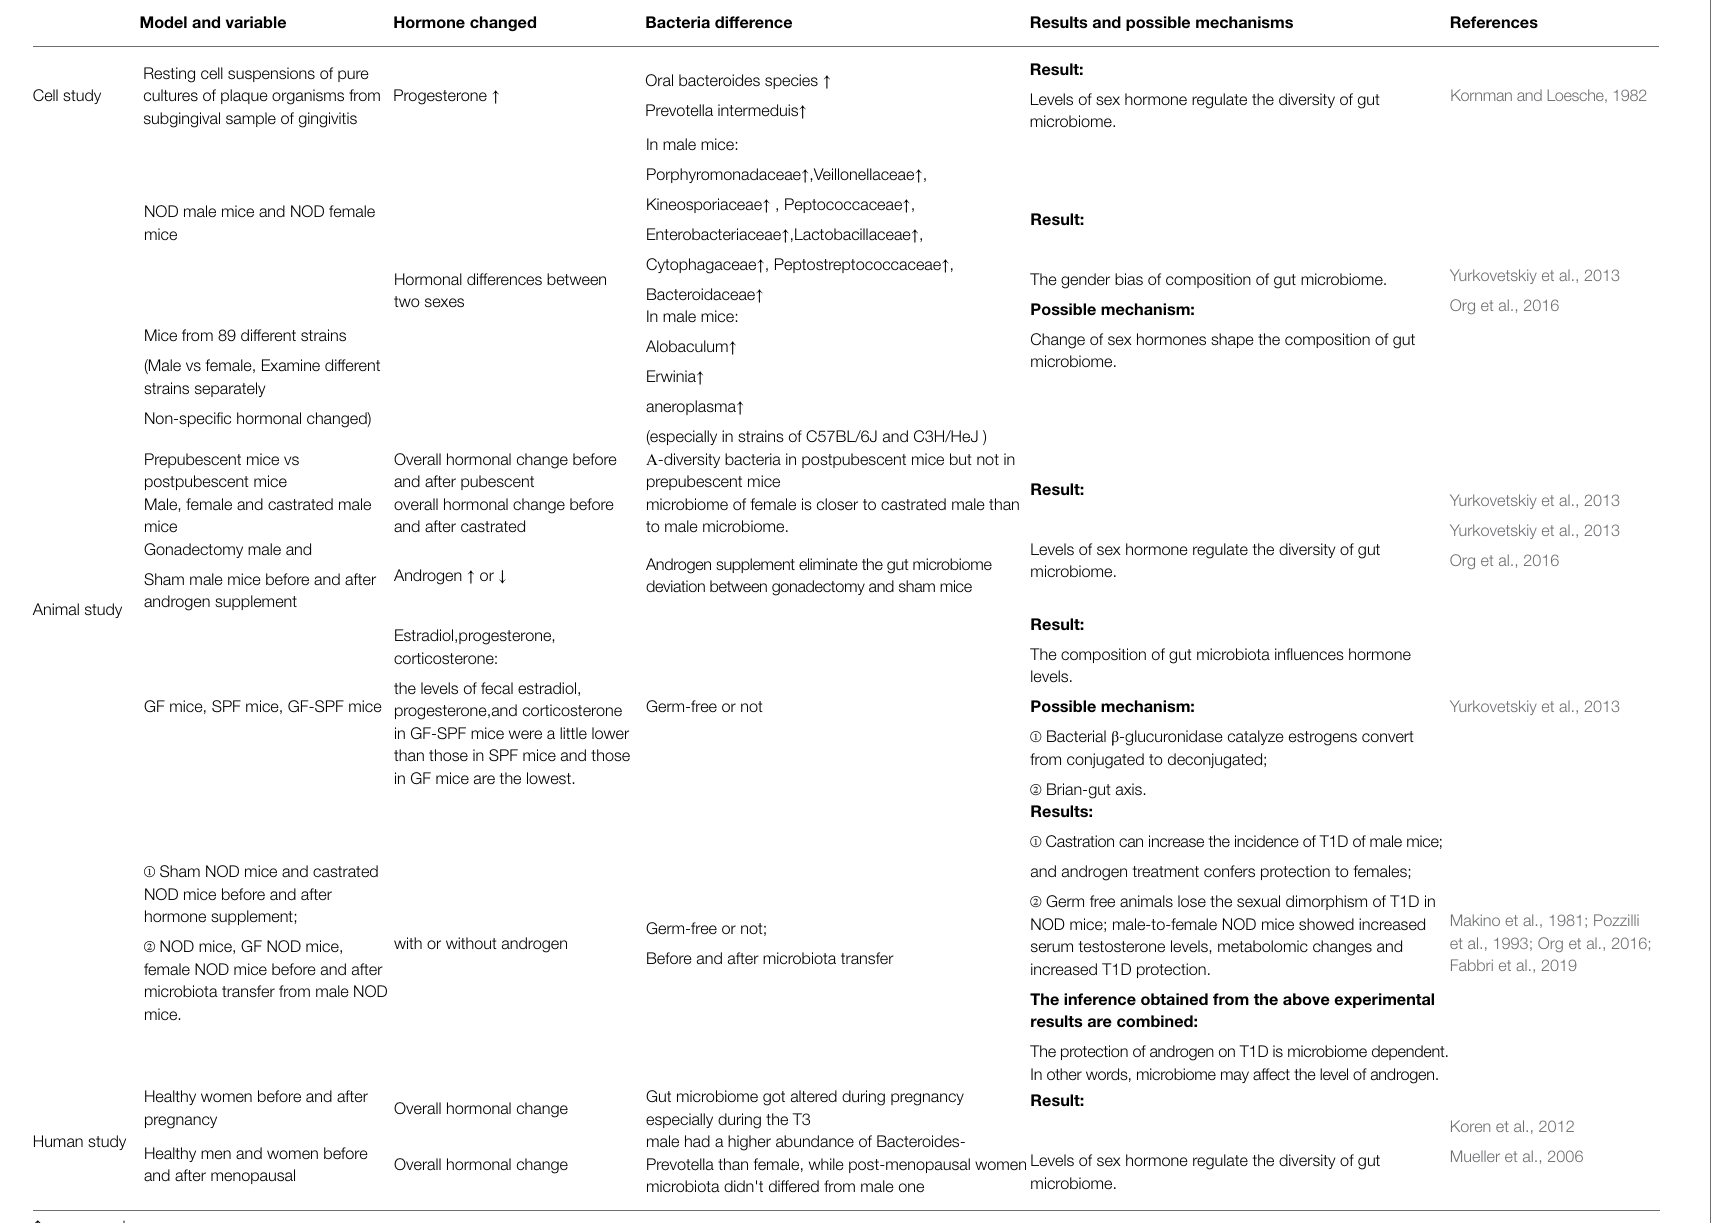
TABLE 1 | Studies on the interaction between gut microbiome and sex